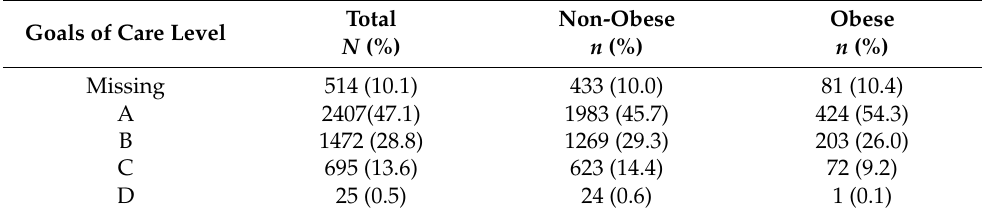
Table 4. Admission goals of care categories by obesity status ( n = 5113). Goals of Care